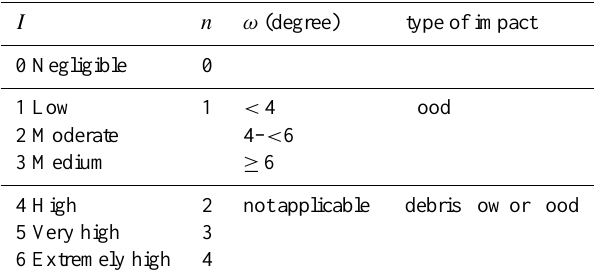
Table 7. Impact susceptibility rating I . n stands for the number of relationships (see Table 5) predicting an impact on the considered pixel, ω stands for the average slope angle from the lake to the con- sidered pixel. Since the relationship designed for floods predicts the longest travel distance and not all LOFs evolve into debris flows, the impact type for pixels with n ≥ 2 can be flood or debris flow.